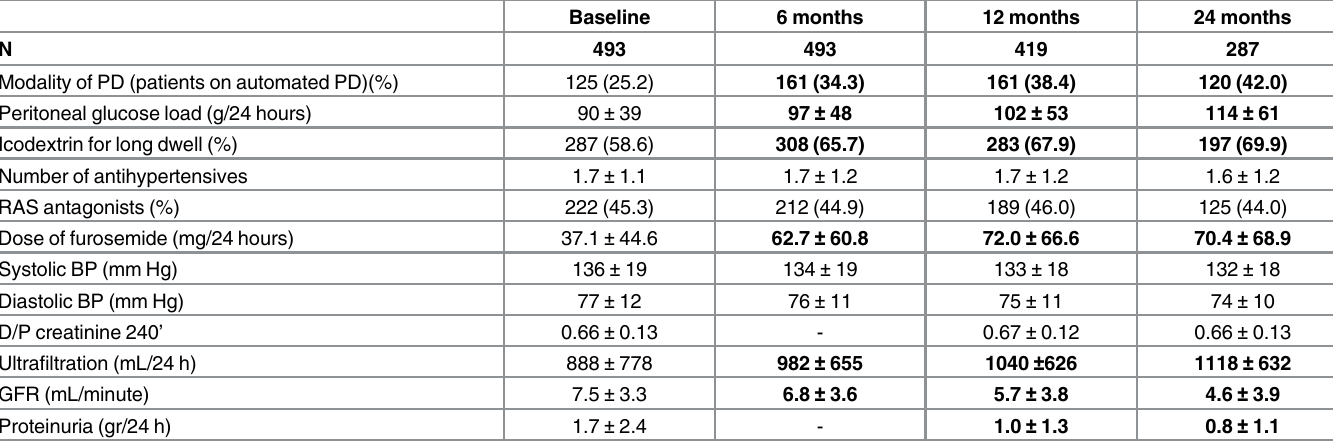
Table 2. Study population. Time-dependent variables.